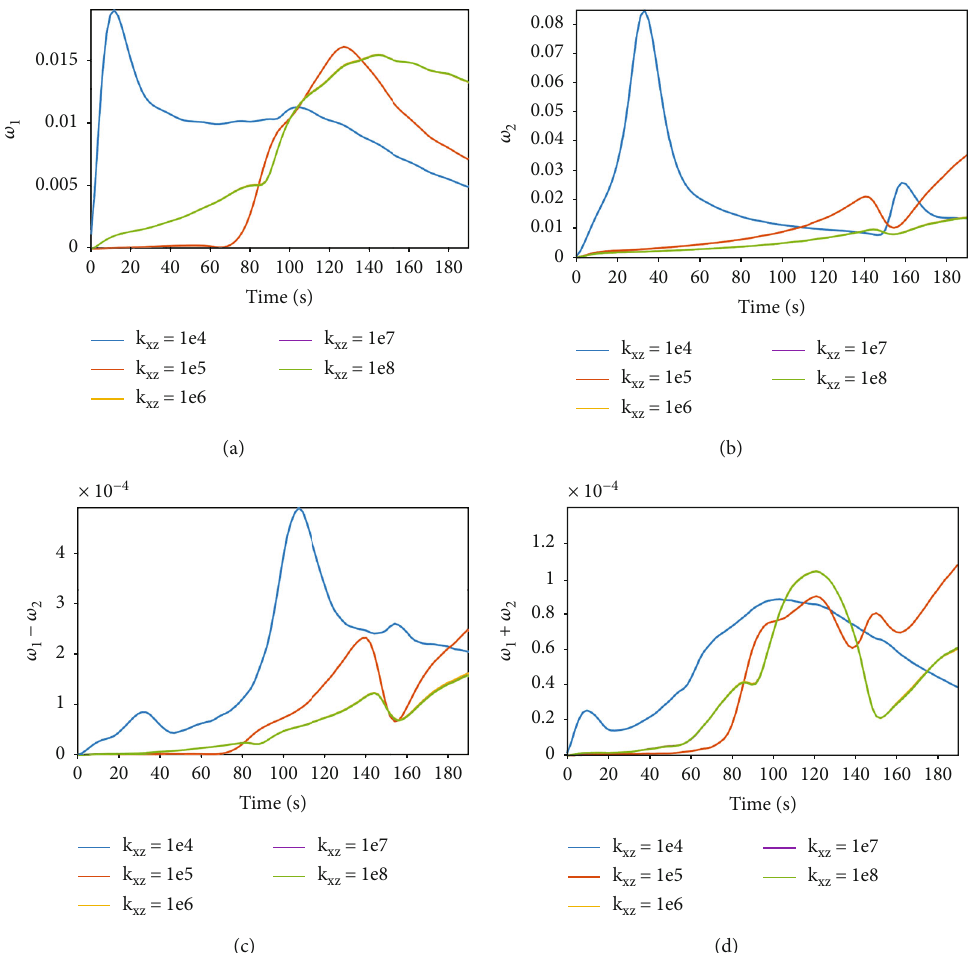
ω ω − ω ω + ω 1 ; (b) 2 ; (c) 1 2 ; (d) 1 2